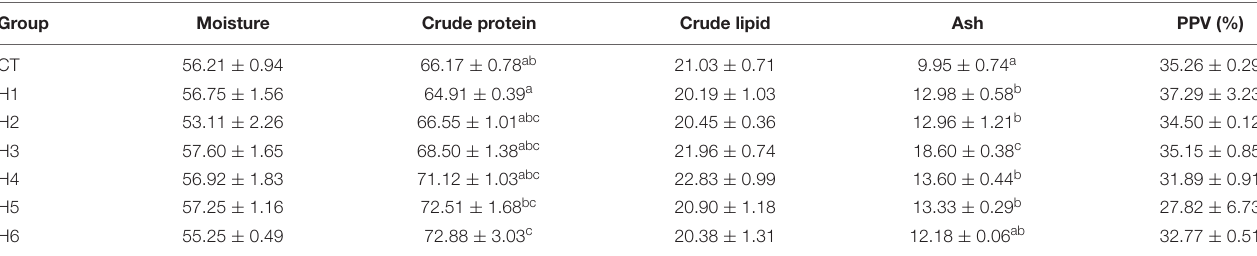
TABLE 7 | Effect of hydrolyzed fish protein powder on the body composition of juvenile pearl gentian hybrid grouper. Group Moisture Crude